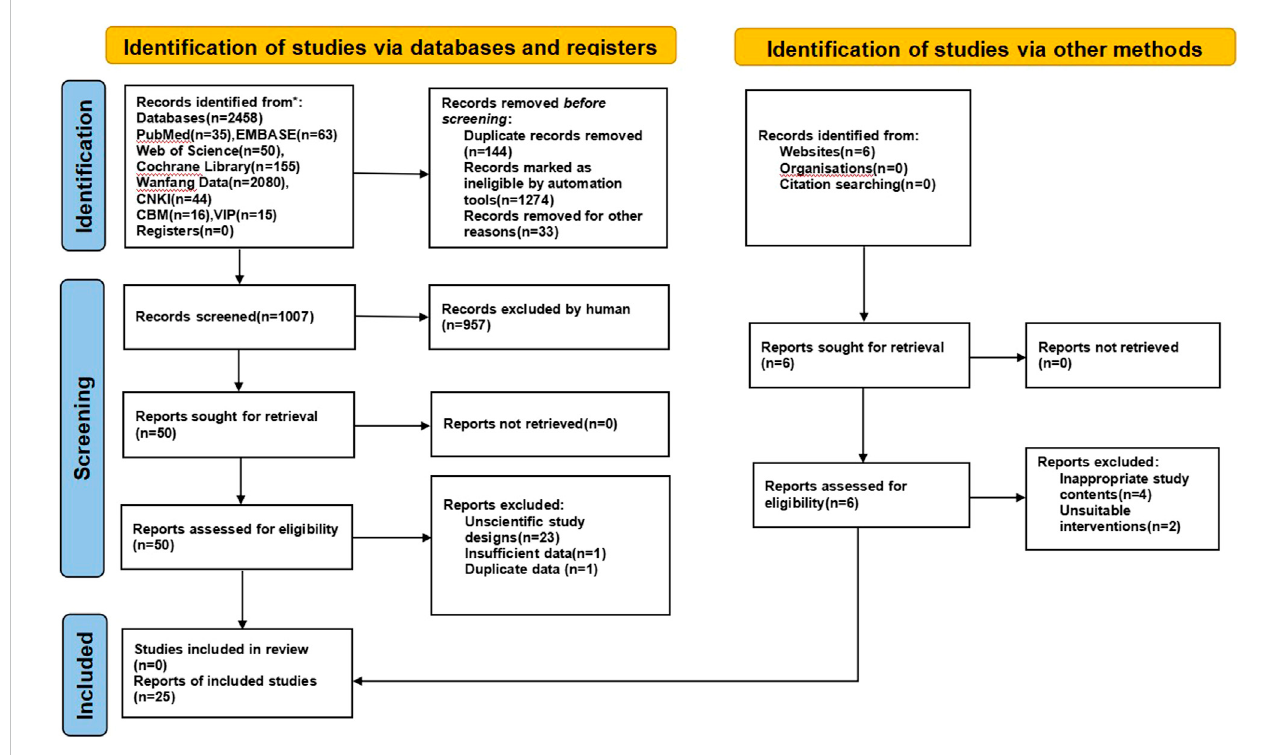
FIGURE 1 Flowchart of study